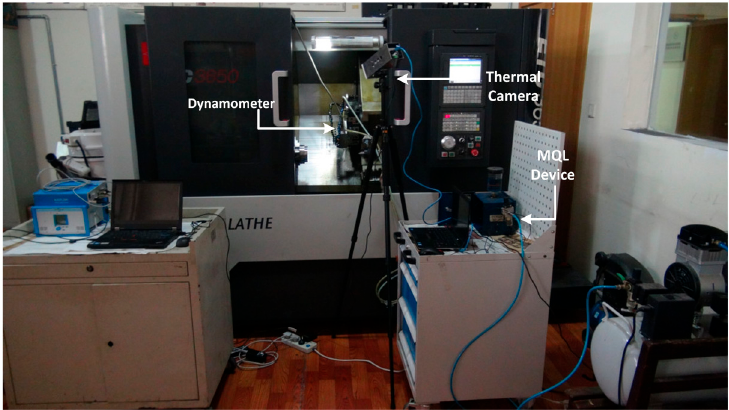
Figure 3. Experimental set-up for turning TC11.